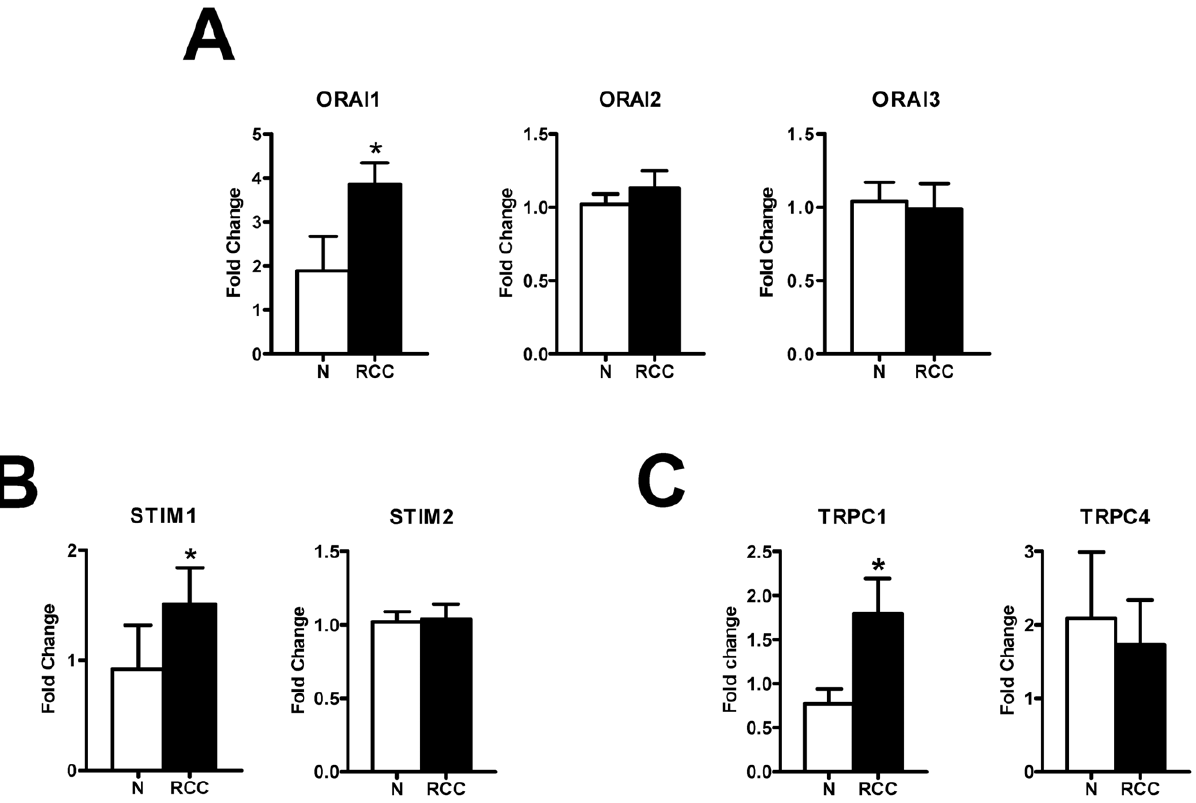
Figure 3. The expression of Orai1-3, Stim1-2, TRPC1 and TRPC4 in endothelial progenitor cells isolated from healthy donors and from patients suffering from renal cellular carcinoma. qRT-PCR showing increased expression of Orai1 (A), Stim1 (B), and TRPC1 (C) mRNA in RCC-EPCs compared to N-EPCs. Conversely, Orai2 (A), Orai3 (A), Stim2 (B), and TRPC4 (C) are not differently expressed in RCC-EPCs. Bars represent mean 6 SE of at least 4 different experiments each from different RNA extracts. The asterisk indicates p , 0.05 vs . N-EPCs (ANOVA followed by Newman-Keuls’ Q test). The PCR products were of the expected size: Orai1, 257 bp; Orai2, 334 bp; Orai3, 159 bp; Stim1, 347 bp; Stim2, 186 bp; TRPC1, 307 bp and TRPC4, 300 bp [27].